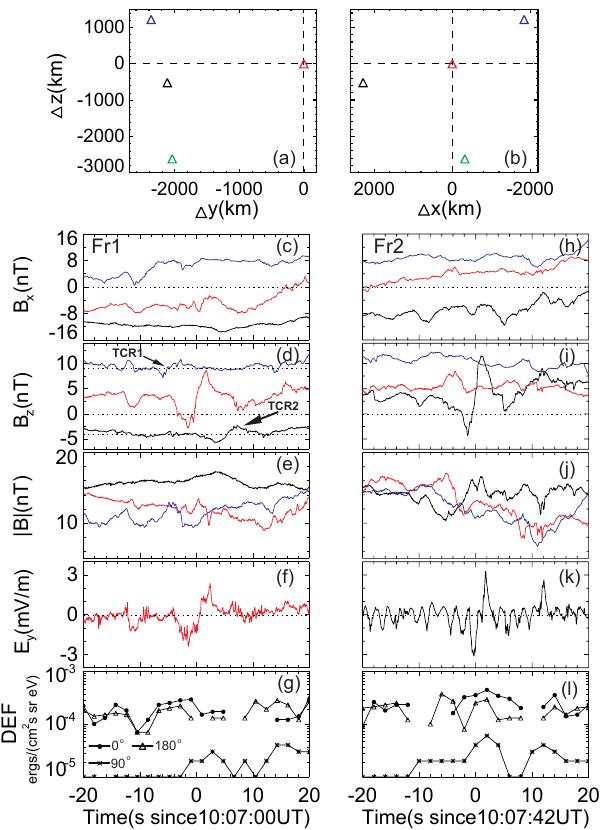
Fig. 3. Relative position of the four Cluster satellites (C1, C2, C3, and C4) at 10:07UT in the (a) z – y plane and (b) z – x plane of the GSM coordinates are shown. Magnetic field, electric field and elec- tron angle distribution data around Fr1 and Fr2 are displayed in (c) – (g) and (h) – (l) , respectively. For Fr1, magnetic field component (c) B x and (d) B z , and (e) magnetic field magnitude | B | at C1, C2, and C4, (f) electric field E y in the spacecraft spin coordinates from C2, and (g) electron differential energy fluxes from C2 at three direc- tions (0 ◦ , 90 ◦ , and 180 ◦ ) are presented. The energy of the electron fluxes is between 300eV and 6keV. In order to separate the three curves in (d) , the blue and black curves are shifted up and down 6nT, respectively. Please note that both blue and black curves were above zero horizontal dashed line ( B z > 0). The data around Fr2 are shown in the same format in (h) – (l) . Because Fr2 were observed by C1, E y and electron fluxes at C1 are represented in (k) and (l) , re- spectively. Again, the blue curve in (i) are moved up 6nT. The small sine fluctuations of E y in (k) are formed due to the failure of probe 1 onboard C1. The data gap in Fig. 3g and l means no data collected.